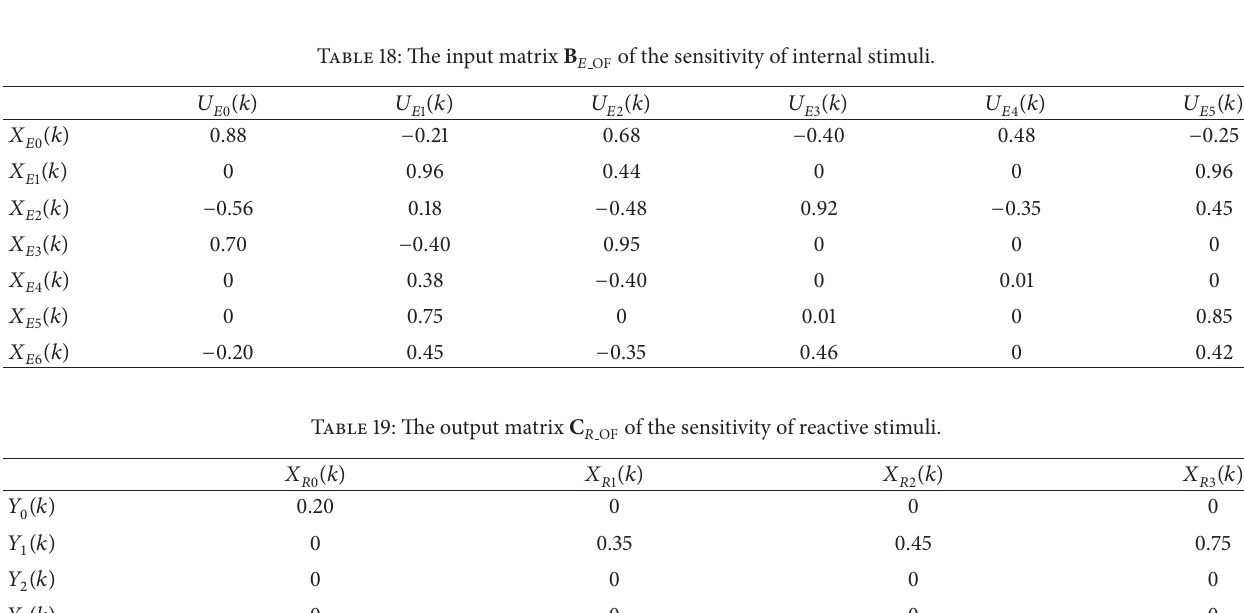
Table 18: The input matrix B 𝐸